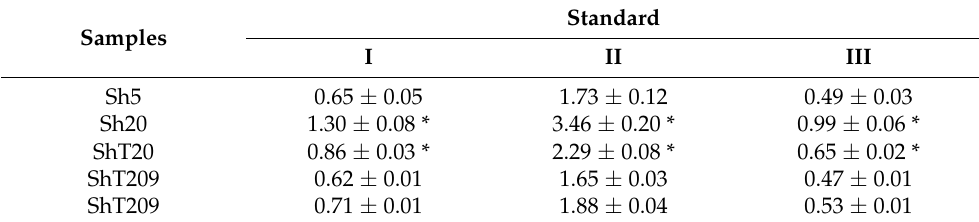
Table 1. Antioxidant activity (mg/g according to the standard) of shungite extracts (amperomet- ric